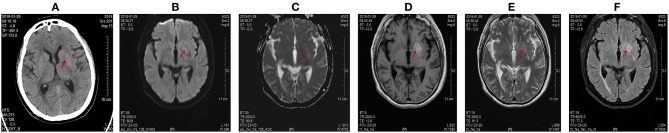
Computed tomography (CT) scans and magnetic resonance imaging (MRI) images of the brain on January 29, 2019. Abnormal signals were marked by red arrow. (A) The disappearance of the high signal intensity in the left lentiform nucleus on CT scans. The CT value of abnormal lesion center was 36.9 Hu. (B) The left lentiform nucleus showed an equal signal intensity on DWI scans. (C) The left lentiform nucleus showed an equal signal intensity on ADC images. The ADC value of the abnormal lesion center was 0.805 * 10−3 mm2/s. (D) The left lentiform nucleus showed a high signal intensity on axial T1-weighted images, but the range was slightly extended. The range of this abnormal signal was about 22.0 mm * 12.4 mm. (E) The lesion of the left lentiform nucleus changed from low signal to high signal on T2-weighted scans. (F) The lesion of the left lentiform nucleus changed from low signal to high signal on T2-FLAIR images.